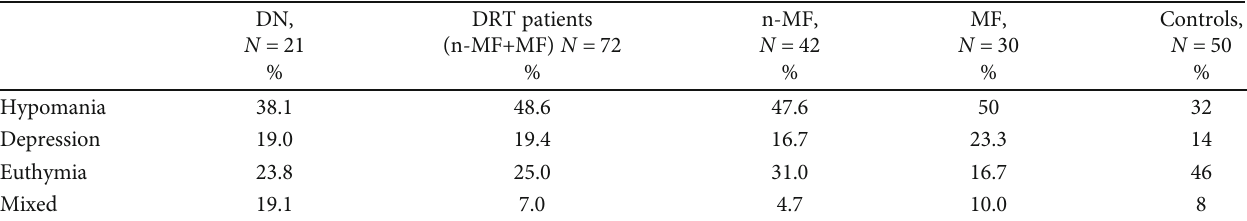
Table 3: Subject distribution among mood